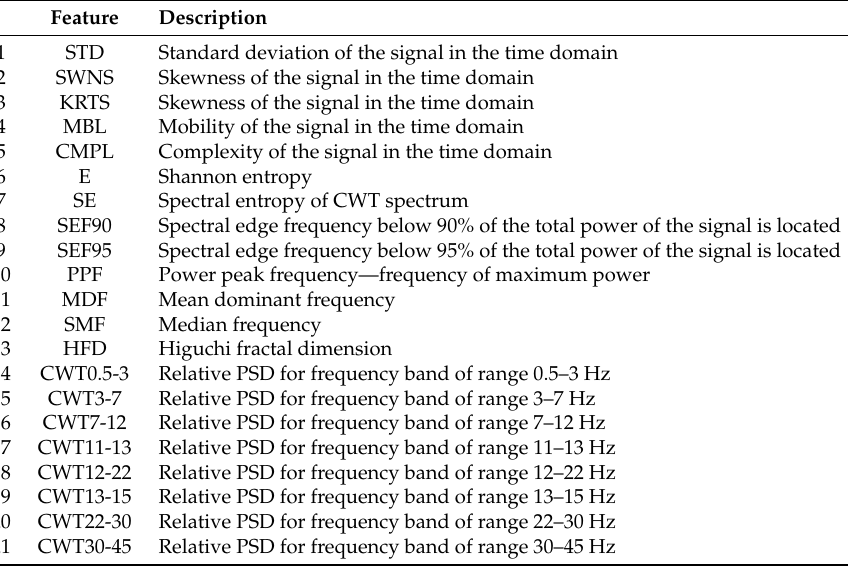
Table 2. List of extracted